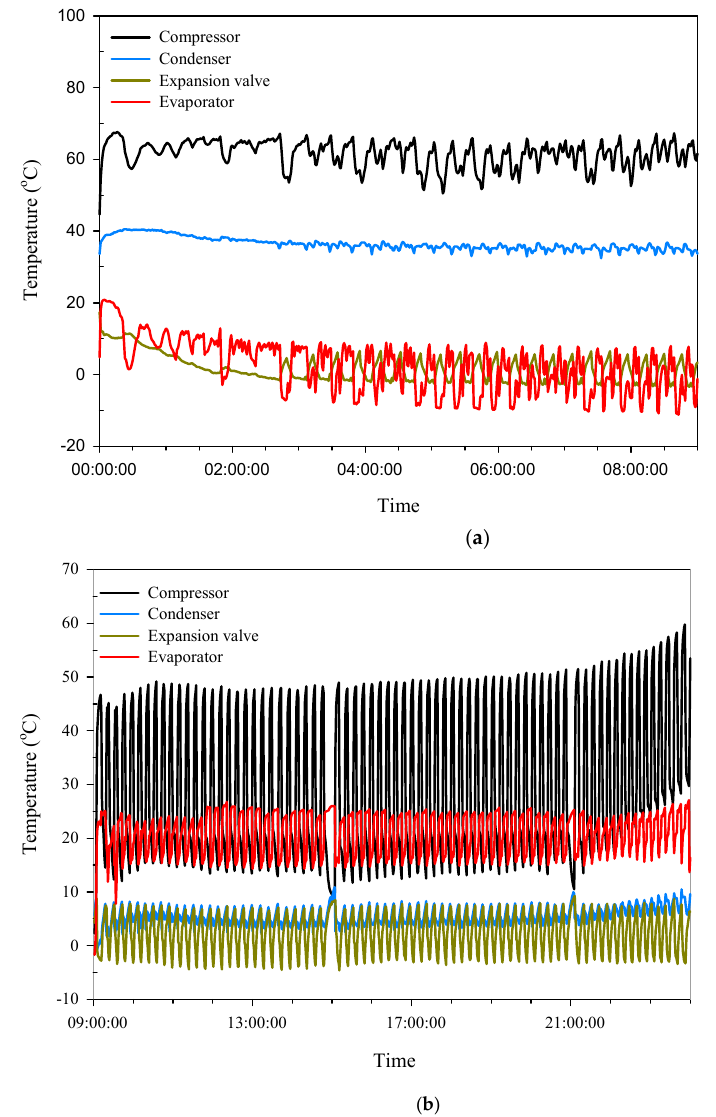
Figure 6. Inlet/outlet temperature of the four major refrigeration components. ( a ) Ice storage mode; ( b ) Melting mode.